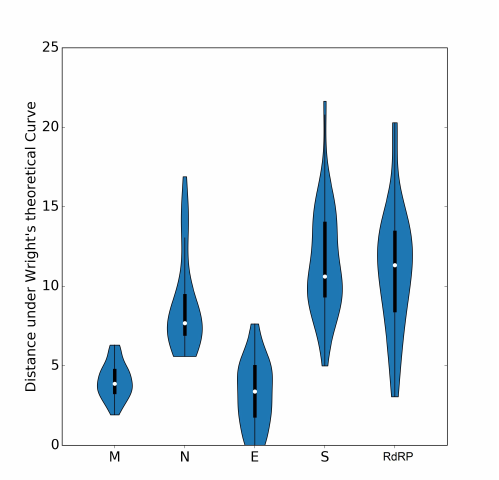
Figure 6. Violin plots of the distances of genes M, N, S, E and RdRP from Wright’s theoretical